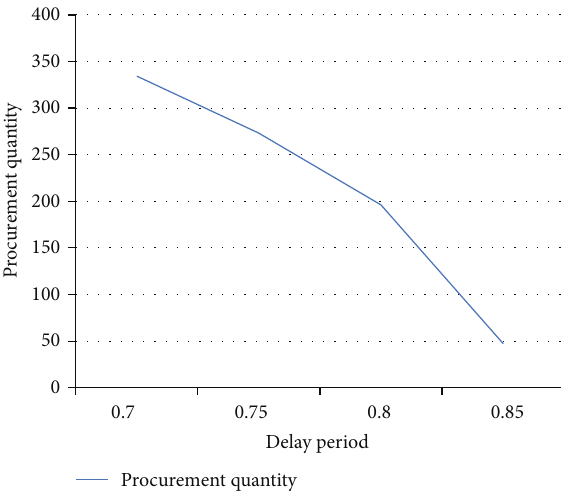
Figure 6: Procurement quantity versus delay